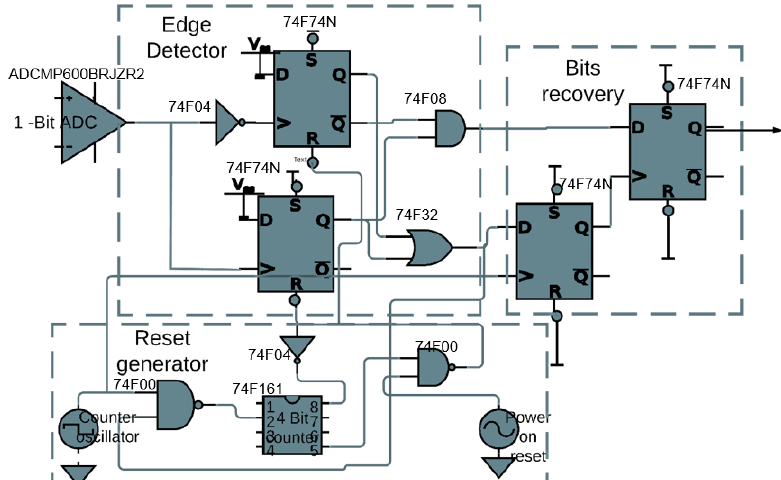
Figure 7. Downlink receiver demonstrator: schematic.